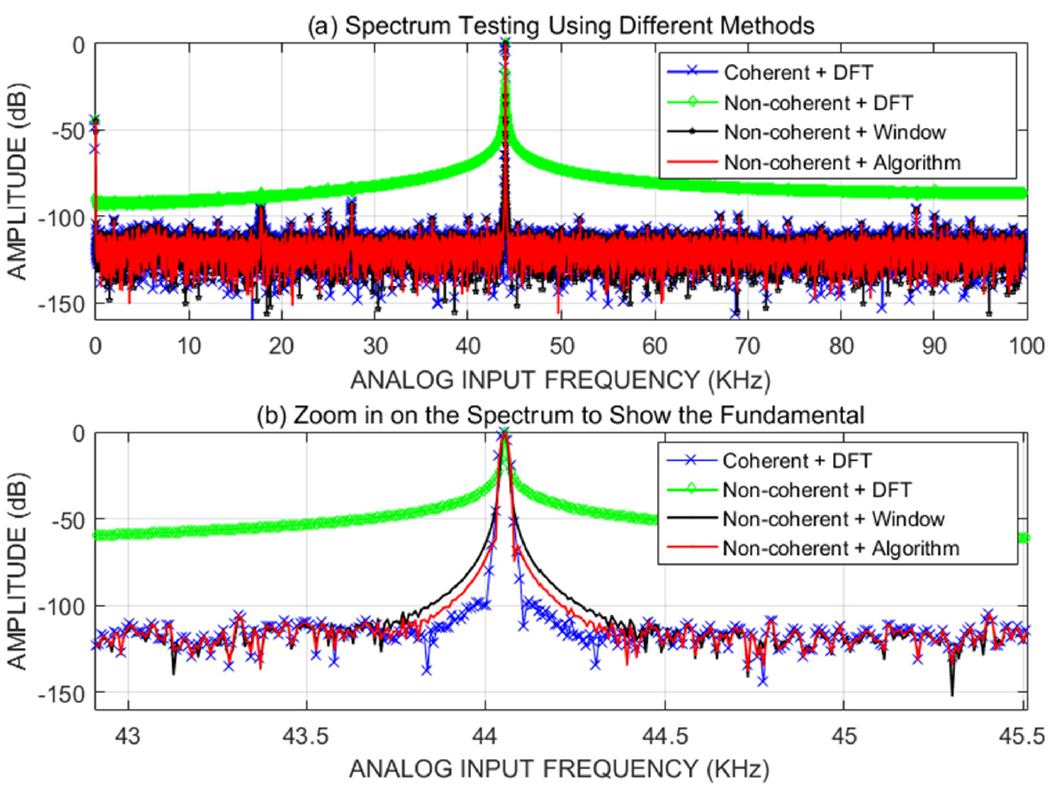
Figure 9. Spectrum tests using different test methods: ( a ) full spectrum; and ( b ) amplified fundamental spectrum. Table 2. Dynamic test results.